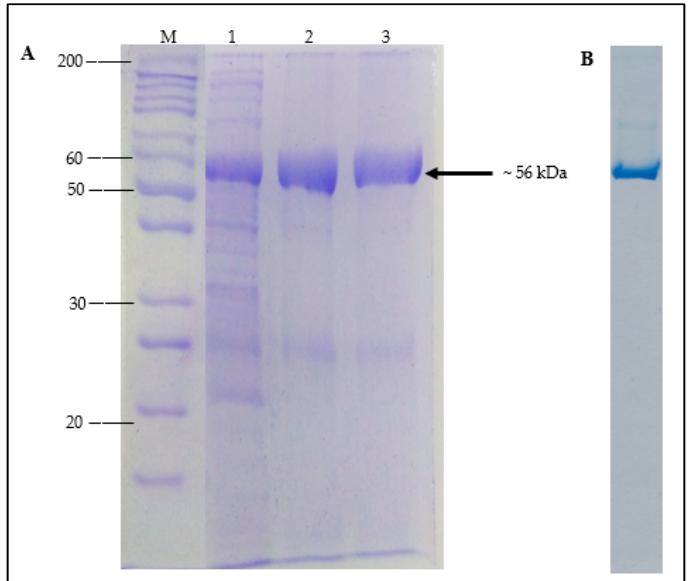
Figure 4. SDS-PAGE analysis of purified A. geothermalis ALDH. ( A ) SDS-PAGE analysis of A. geothermalis ALDH after affinity chromatography step using Ni-Sepharose Fast Flow. Lane M: Un- stained protein molecular weight marker, Lane 1: crude cell lysate, Lane 2: pooled purified, Lane 3: dialysed purified A. geothermalis ALDH. ( B ) Native PAGE of purified A. geothermalis ALDH.